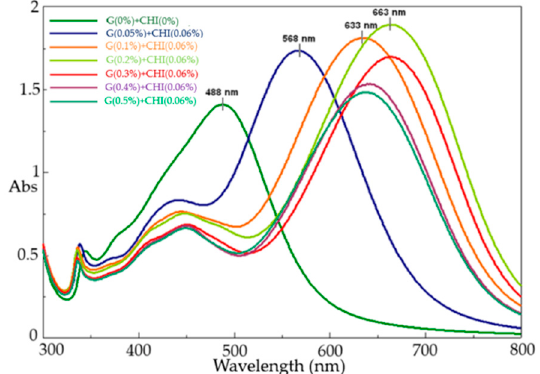
Figure 3. UV-Vis spectra of triangular AgNPs synthesized by different concentrations ratios of mixed gelatin (type B)–chitosan (from 0–0.06 to 3.0–0.06, w/v). Table 1. UV-Vis results of triangular Ag nanoplates synthesized by different concentration ratios of gelatin–chitosan mixture.